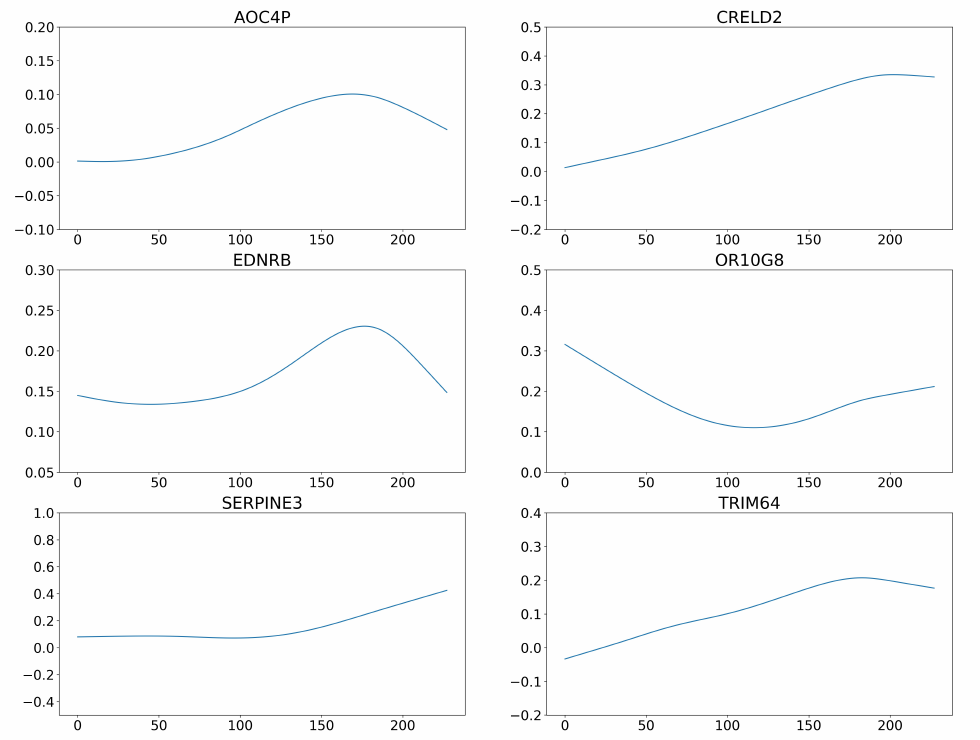
Figure 2. Analysis of the SKCM data using the proposed approach: estimated coefficients of the 6 genes for all subjects. The x -axis represents the subjects, and the y -axis represents the coefficient